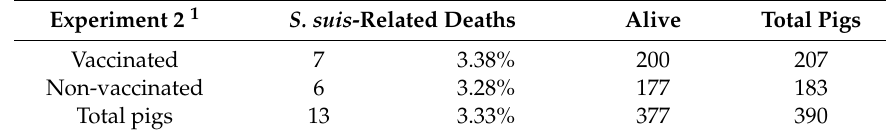
Table 3. Distribution of mortality among piglets from vaccinated and non-vaccinated sows.